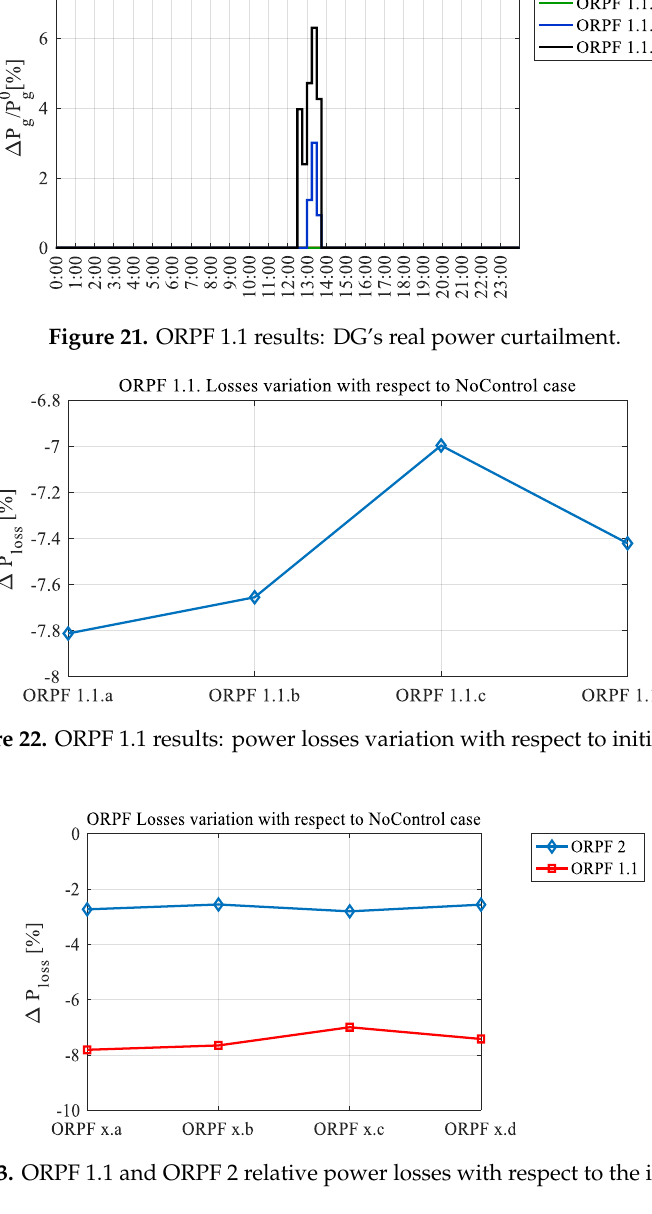
Figure 21. ORPF 1.1 results: DG’s real power curtailment.